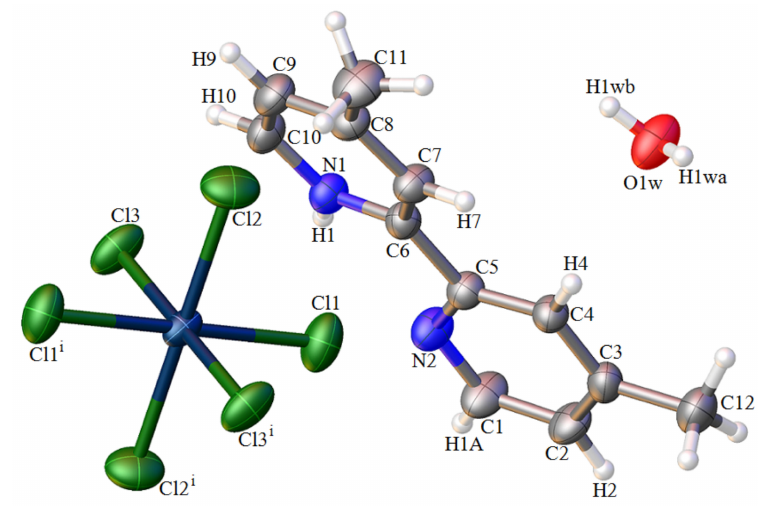
Figure 5. View of the asymmetric unit of complex 3 with the numbering scheme. The thermal probability is drawn at 30%. Symmetry code: i = 2 − x, − y, −